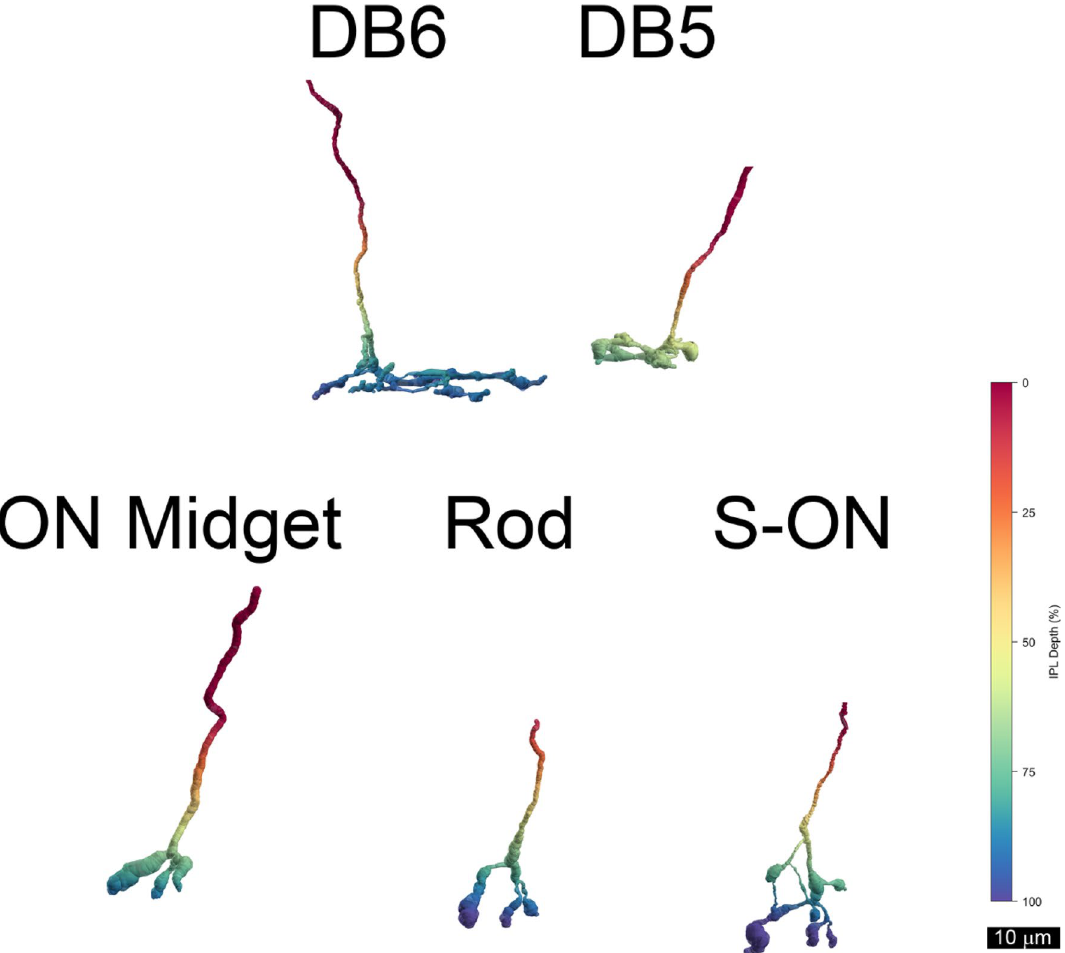
Figure 8. Displaced M1 ganglion cell 2155 received all but one of its excitatory synapses from five types of ON bipolar cells. Note that their axon terminals ramified in S4 (green) and S5 (blue) of the IPL.DB6 = 43031i, DB5 = 52773i, ON midget = 52770i, Rod = 17585i, S-ON = 22103i.